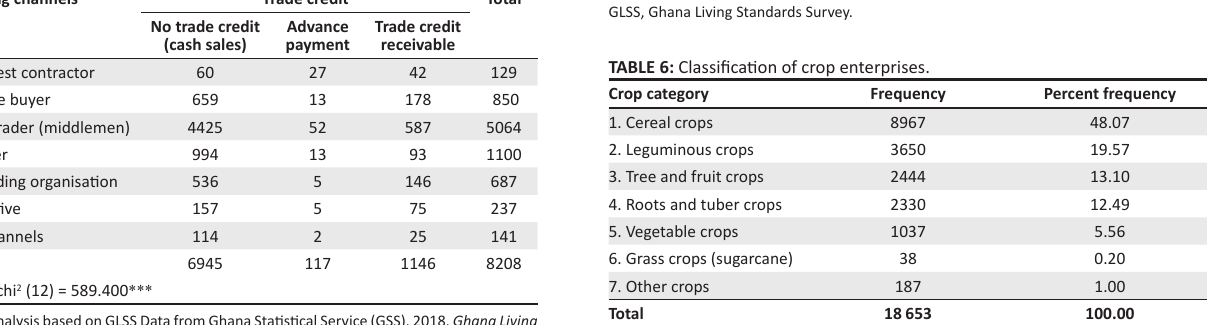
TABLE 4: Trade credit and agricultural marketing channels. Marketing